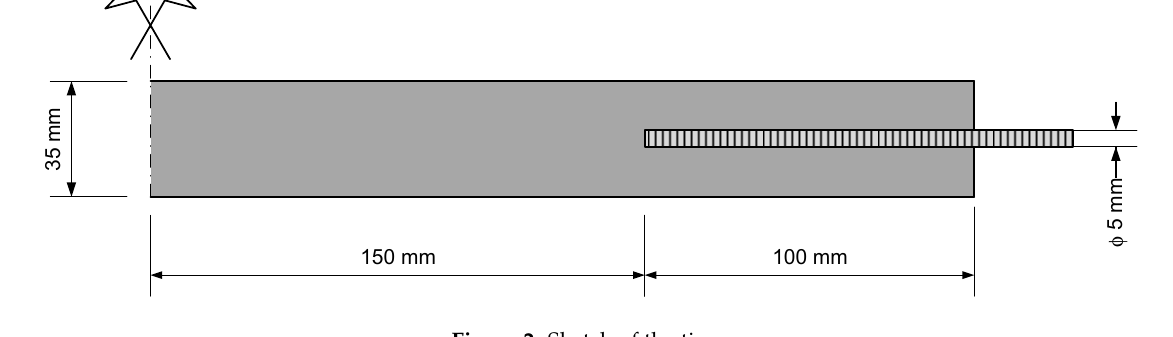
Figure 2. Sketch of the ties.